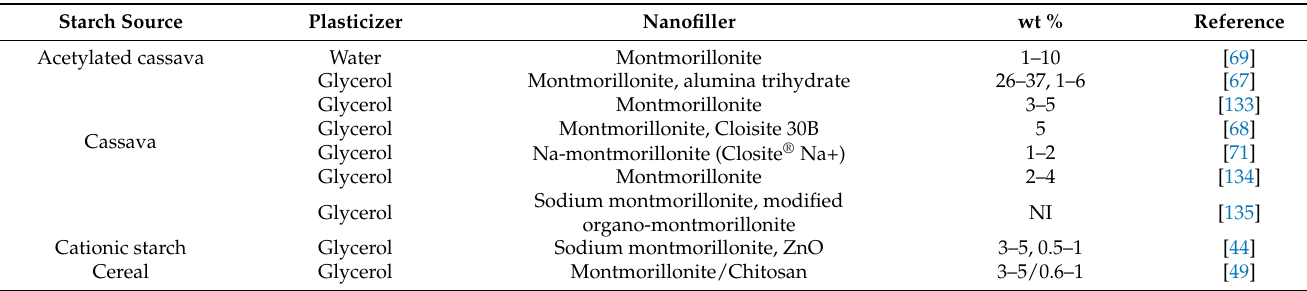
Table 3. Plasticizers and montmorillonite as nanofiller (including their wt %) in most used TPS sources. Starch